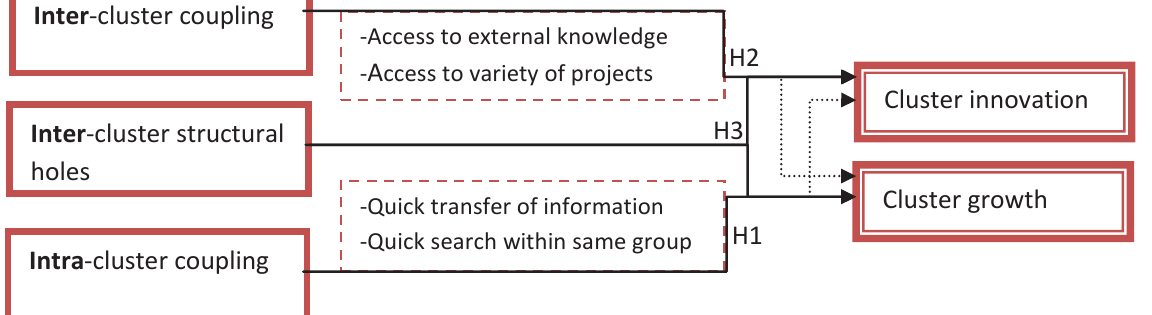
Fig. 3. Illustration of theory design on the impact of the three constructs (intra-group coupling and inter-group coupling, as well as inter-group structural holes) on group growth and